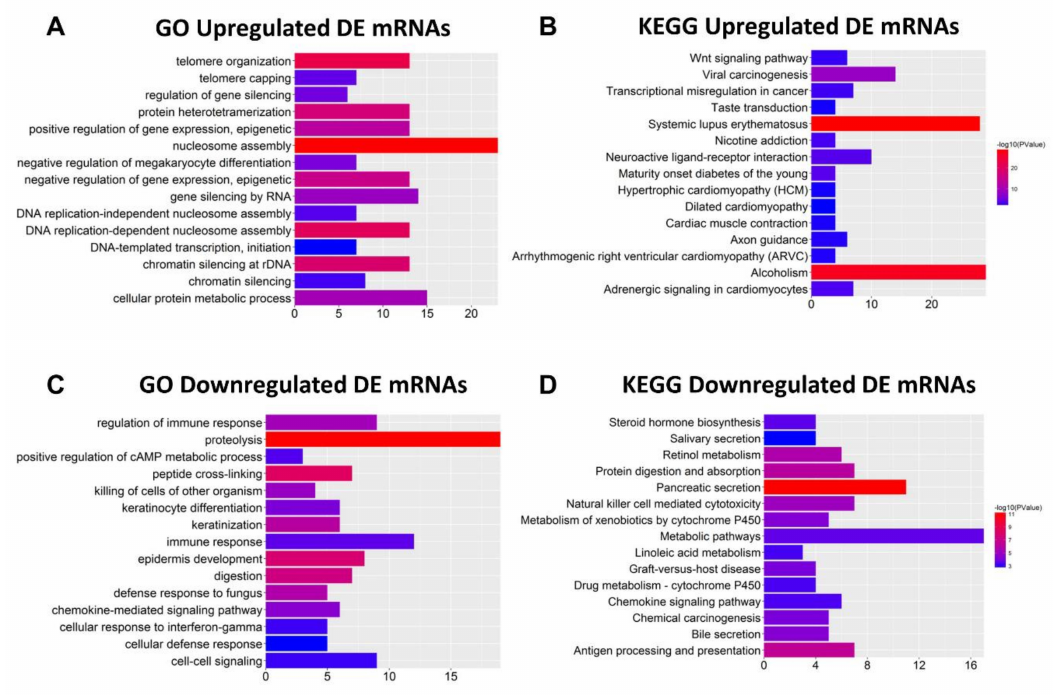
Figure 2. Functions of di ff erentially expressed (DE) mRNAs were analyzed with DAVID and KOBAS bioinformatics resources, respectively. ( A , B ) Top 15 Gene Ontology (GO) and Kyoto Encyclopedia of Genes and Genomes (KEGG) results of upregulated mRNAs, respectively. ( C , D ) Top 15 GO and KEGG results of downregulated mRNAs, respectively. Color from blue to red indicates − log10 ( p ) from low to high. X -axes represent the number of genes involved in each